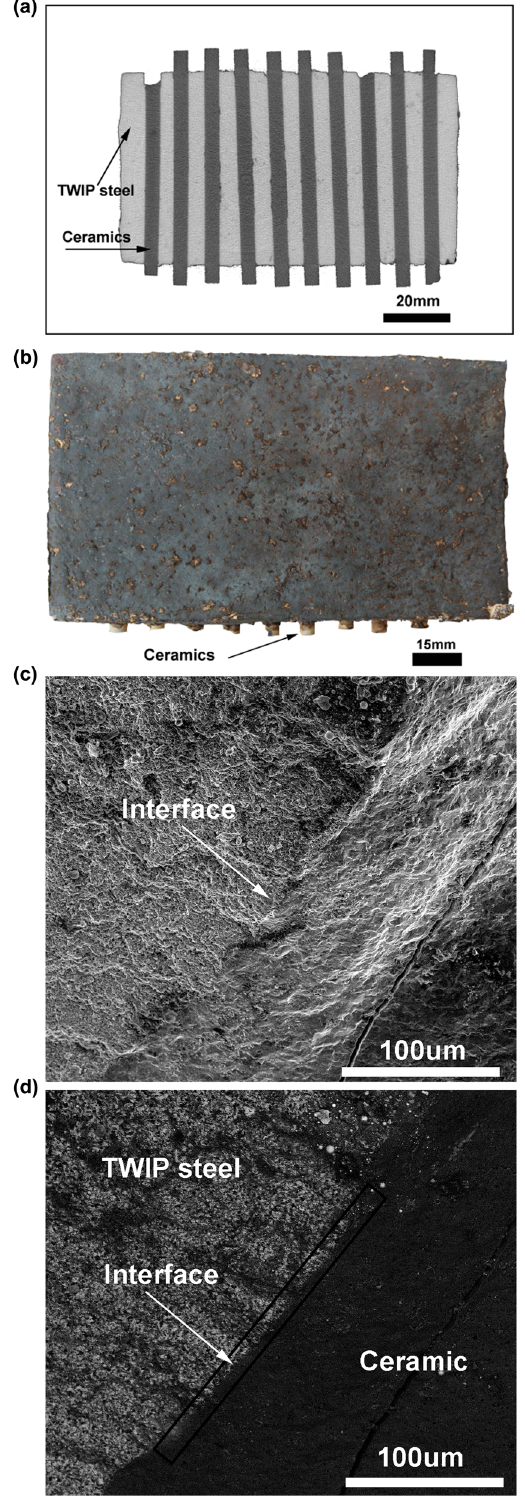
Figure 4: ( a ) PhotographofTWIPsteelcompositestructureand ( b ) non - destructive CT photo of composite structure. ( c ) SEM microstructure, and ( d ) BEI of interface between ceramic bar and TWIP steel matrix.